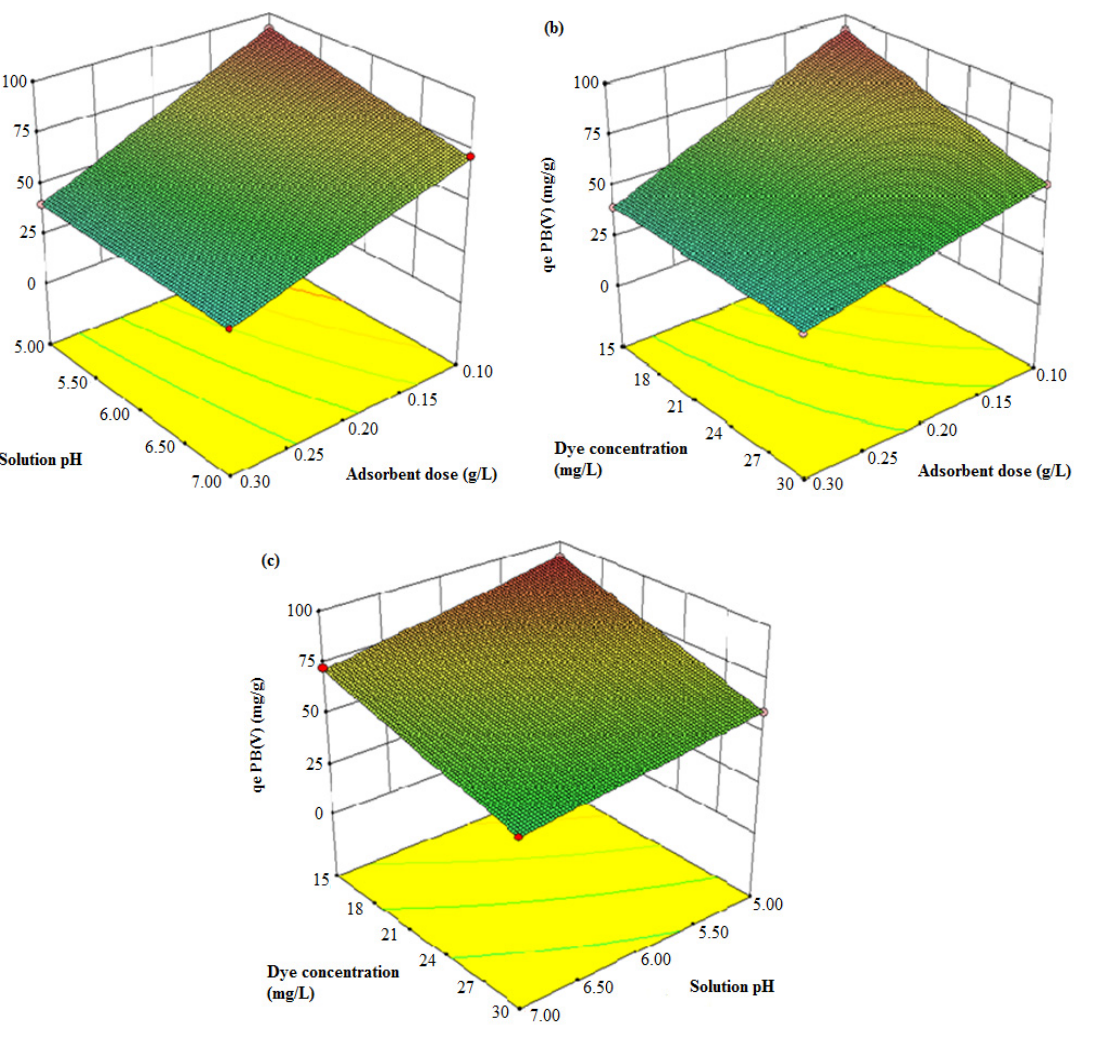
Figure 10. Response surface plots for PBV removal. Solution pH vs. Adsorbent dosage (a), dye concentration vs. Adsorbent dosage (b), and dye concentration vs. Solution pH (c).